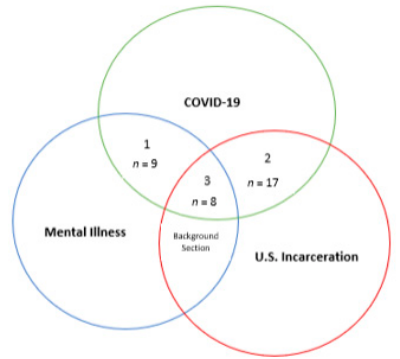
Figure 2. Distribution of the peer reviewed literature by intersection ( N = 34).